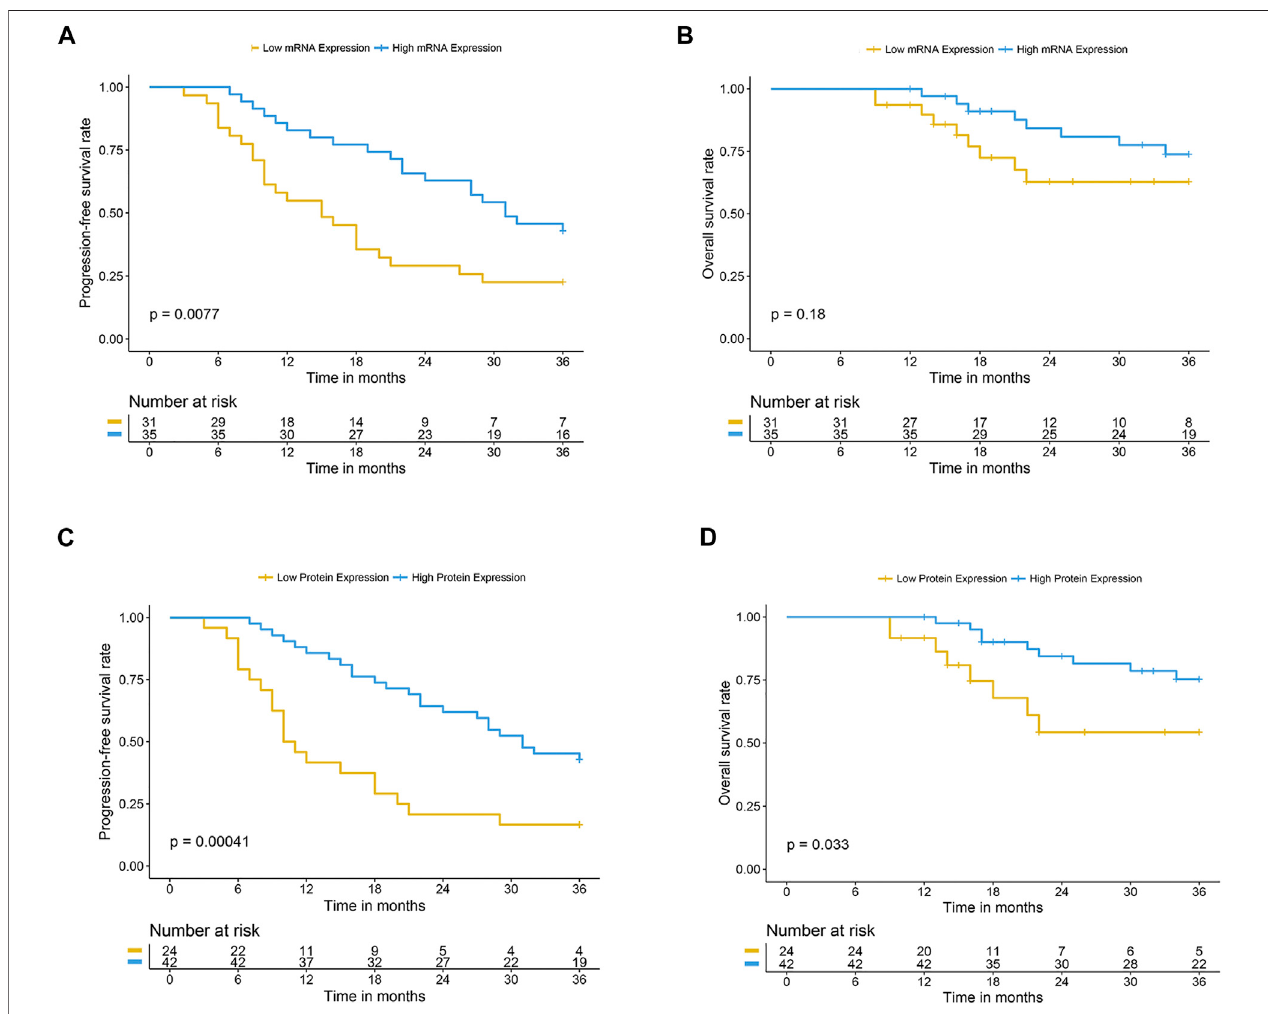
FIGURE 4 | Clinical outcome of patients with high and low expression of OCTN2 treated with oxaliplatin. Kaplan -Meier progression-free survival and overall survival curves in OCTN2 low- and high-expressing groups de fi ned according to the relative mRNA level (A and B) or the staining score (C and D) . Samples with relative mRNA value or staining score ≥ of the median value were classi fi ed as OCTN2 high-expressing tumors.